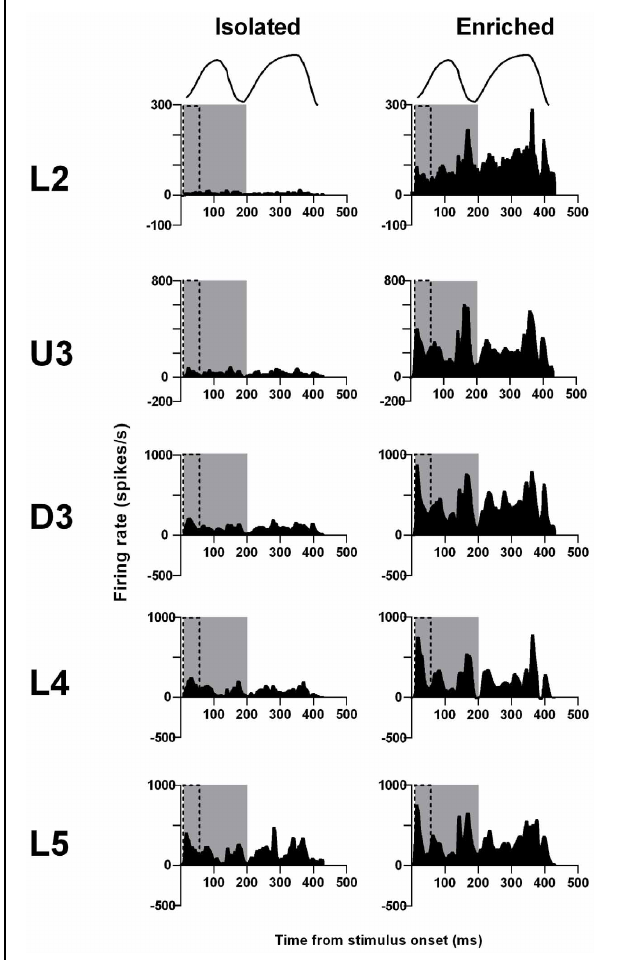
FIGURE 5 | EE effects on pattern of responses evoked by the free whisking stimulus. Response strength increased and was more precisely defined across all laminae after EE. Population Grand PSTHs in response to the trapezoid with the fastest onset ramp velocity (400mm/s) in a specific lamina (indicated to left of panel) in EE and Isolated animals. Laminar designations: L2, Layer 2; U3, Upper Layer 3; D3, Deep Layer 3; L4, Layer 4; L5, Layer 5. Each Grand PSTH was generated by averaging responses across all responsive clusters in that lamina. The two analysis windows used to extract response metrics are represented by the gray shaded box (5–200ms) and the black dashed box (5–50ms). Stimulus waveform is presented above both